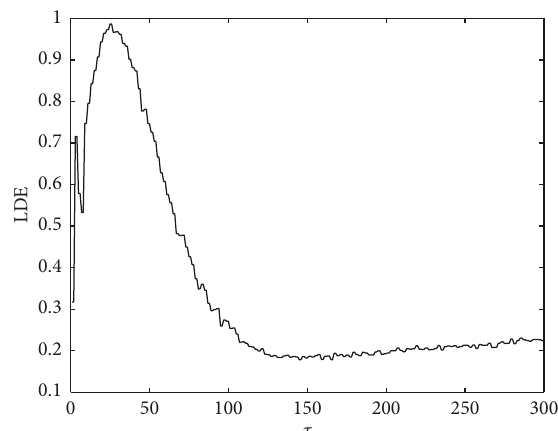
Figure 5: LDE of nsr2db with the changed moving window width τ